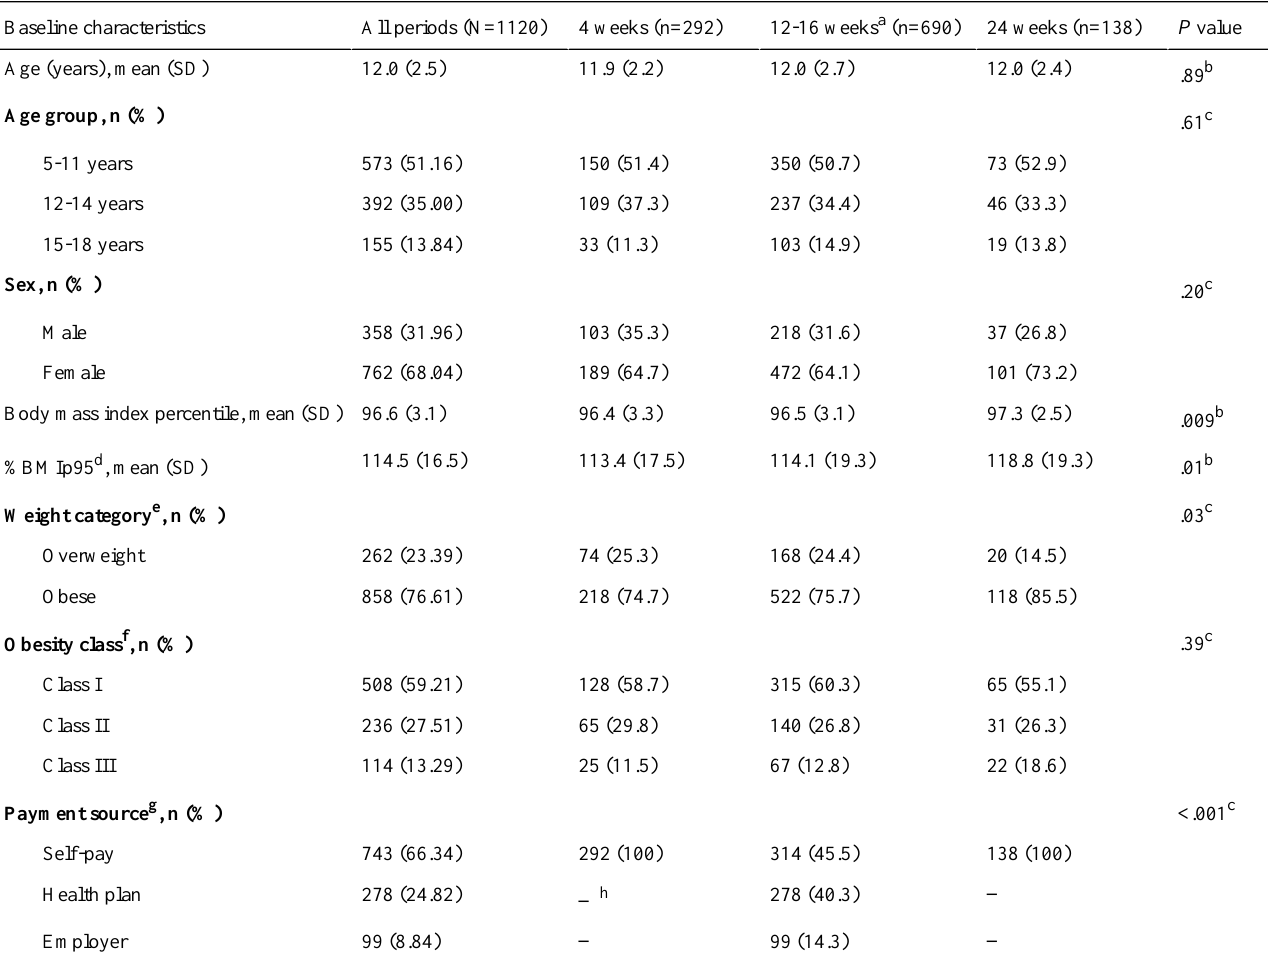
Table 1. Baseline participant characteristics by commitment